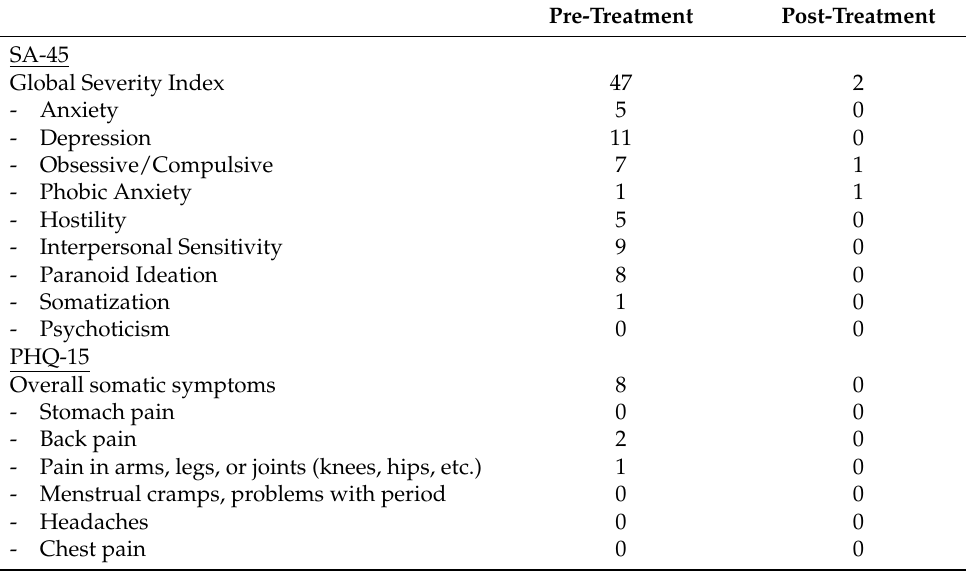
Table 2. Psychological and somatic symptoms at pre- and post-treatment